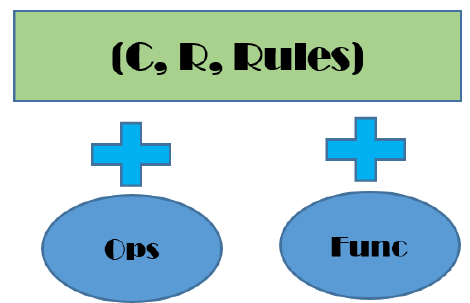
Figure 2. Integrating the kernel and the knowledge of operators and functions.